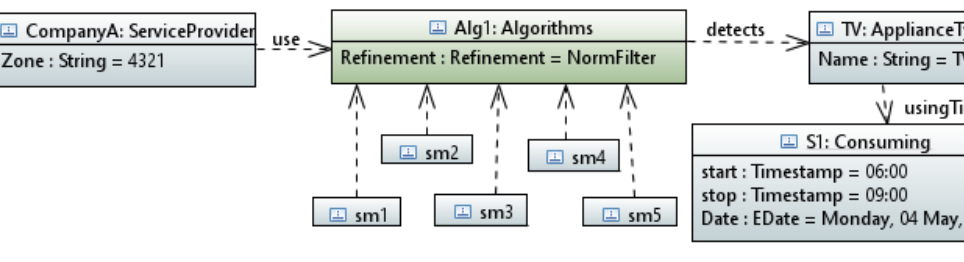
Figure 15. UML object diagram of a group of